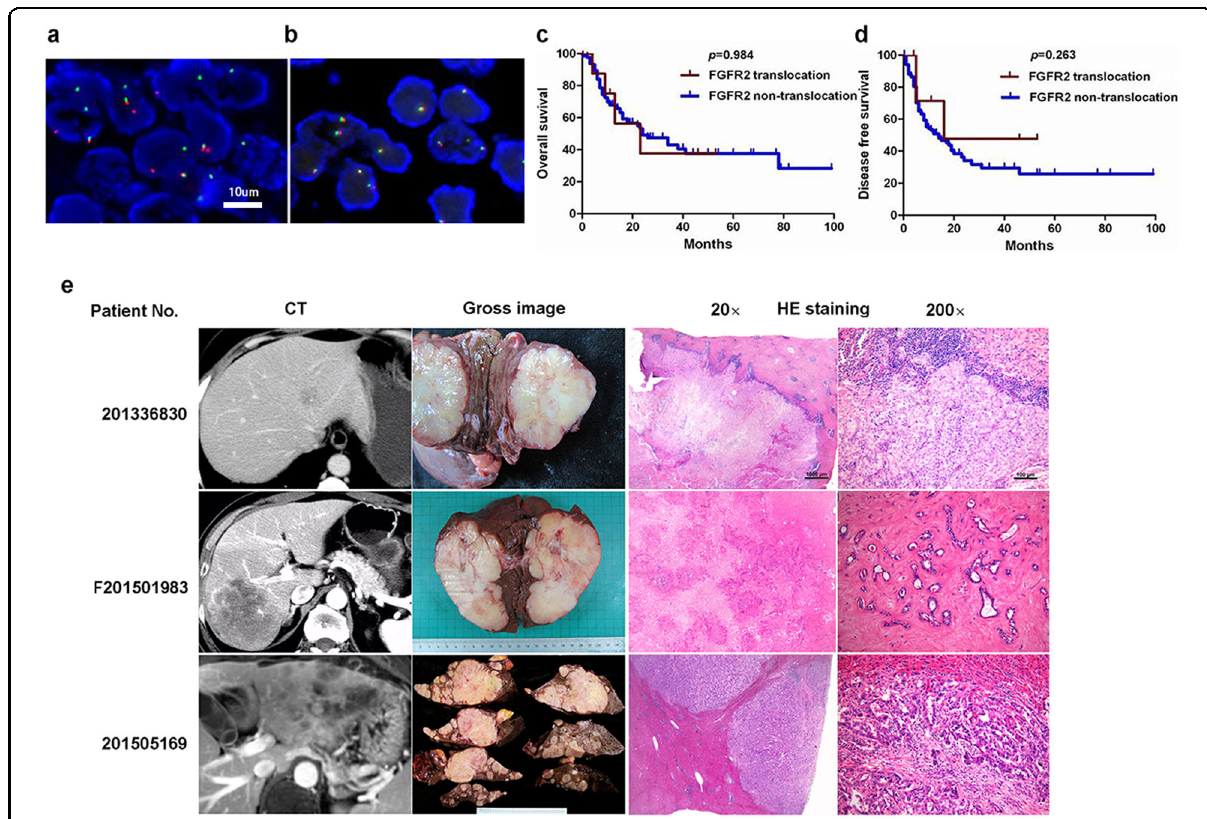
Fig. 1 Clinical subtypes in cholangiocarcinoma. Green and red spots indicate the genomic location of 5 ’ and 3 ’ FISH probes for the FGFR2 gene. Distinct orange and green signals in more than 20% of the tumor cells represent FGFR2 rearrangement. Schematic representation of FGFR2 gene translocation ( a ) and non-translocation ( b ). Overall survival curve ( c ) and disease-free survival curve ( d ) strati fi ed by FGFR2 translocation and non- translocation cases in ICCs (Kaplan – Meier method). The radiologic, gross and histopathologic (20× and 200×) images of three representative patients whose tumor possessed an FGFR2 translocation ( e ). Three ICCs, which respectively numbered No. 201336830, No. F201501983, and No. 201505169 showed small, large, and multiple tumors, in radiologic or gross morphology, were all mass-forming (MF) type. For histological classi fi cation, these were all pancreaticobiliary type adenocarcinoma as presented in 20× and 200× HE